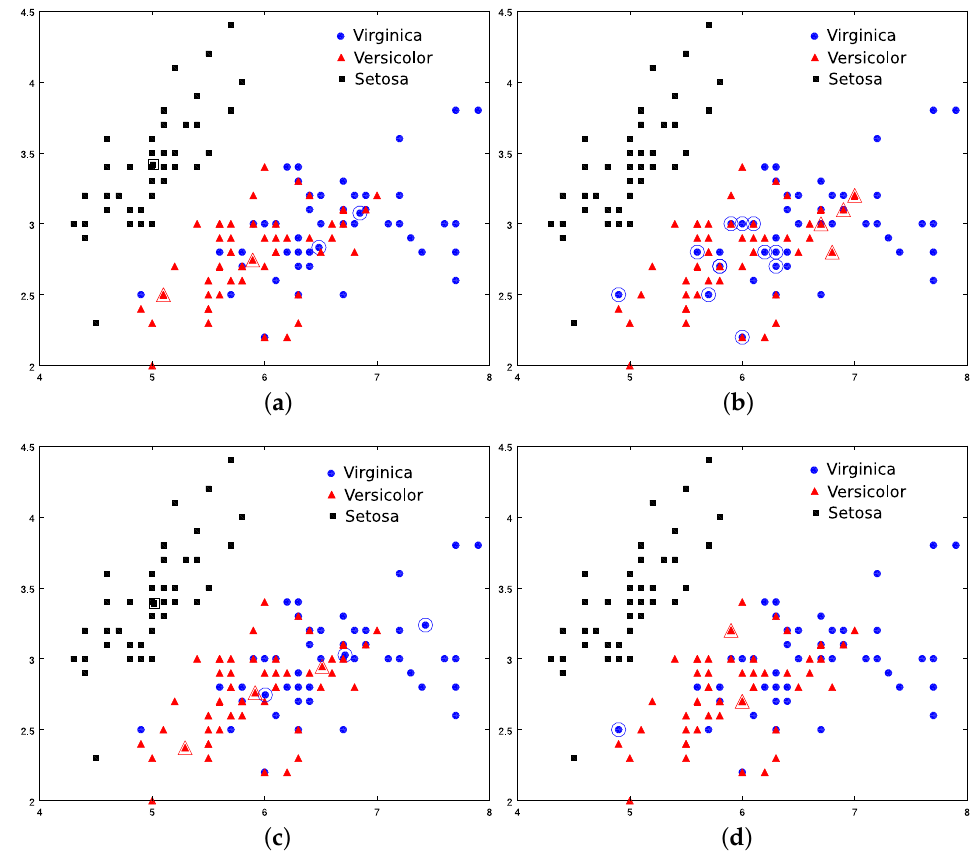
Figure 4. ( a ) Positions of learned prototypes (Simulation 1, Table 3) ( b ) Positions of extracted strong elements (Simulation 1, Table 3) ( c ) Positions of learned prototypes (Simulation 2, Table 3) ( d ) Positions of extracted strong elements (Simulation 2, Table